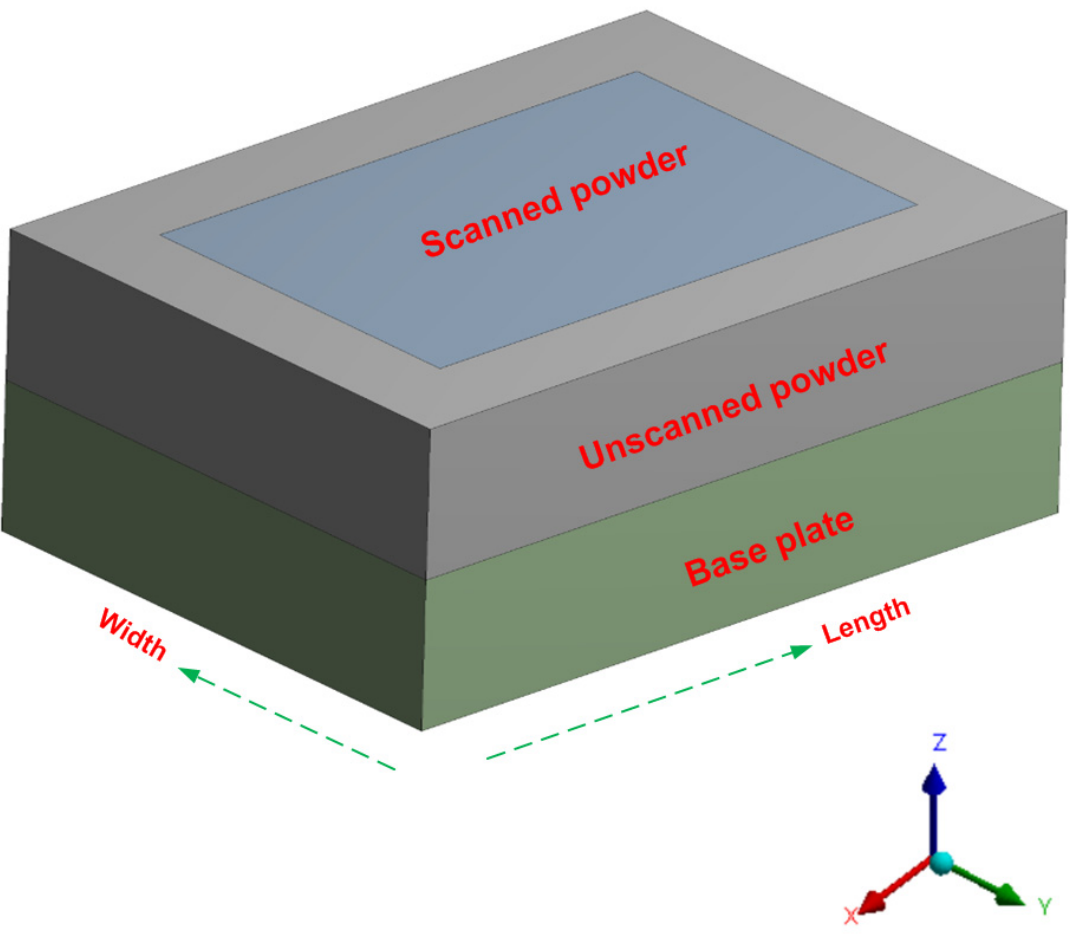
Figure 2. The model geometry used in the analysis (not to scale). Table 2. Numerical model geometry dimensions.